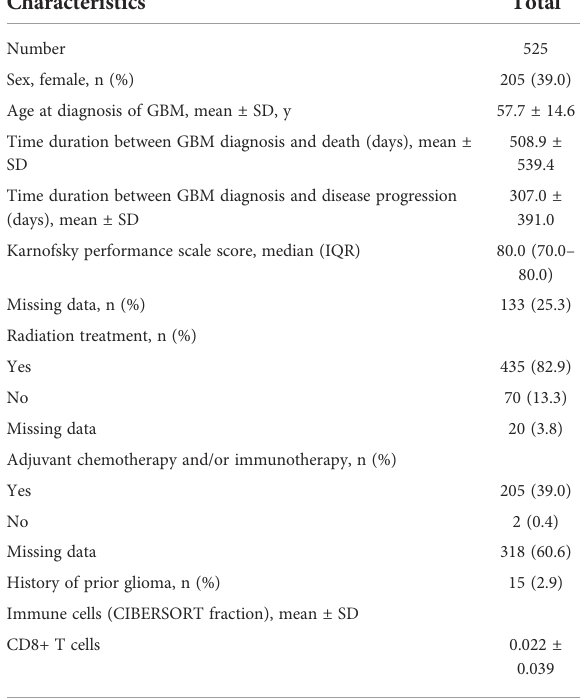
TABLE 1 Clinical characteristics of the study patients with